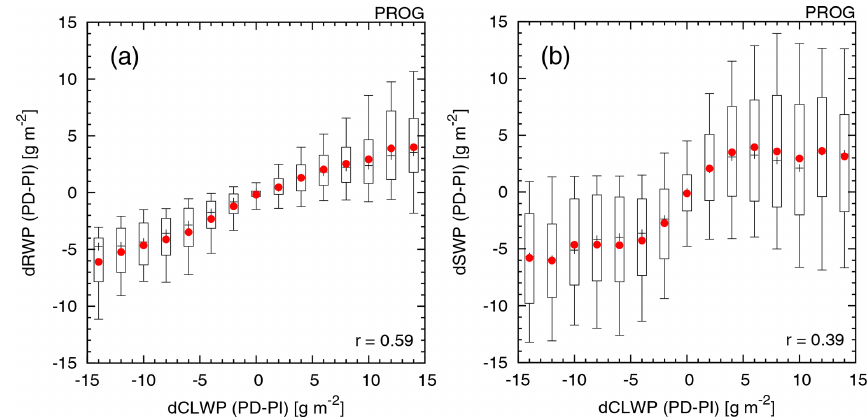
Figure 3. Relationship between the change in annual mean CLWP and that in annual mean (a) RWP and (b) SWP, from the change in aerosols from PI to PD conditions, simulated using the PROG scheme. Box–whisker plots represent the 10th, 25th, 50th (black “ + ”), 75th, and 90th percentiles of the data within each bin based on the annual mean. Plots in red show the mean. The correlation coefficient ( r ) is given in the figure.